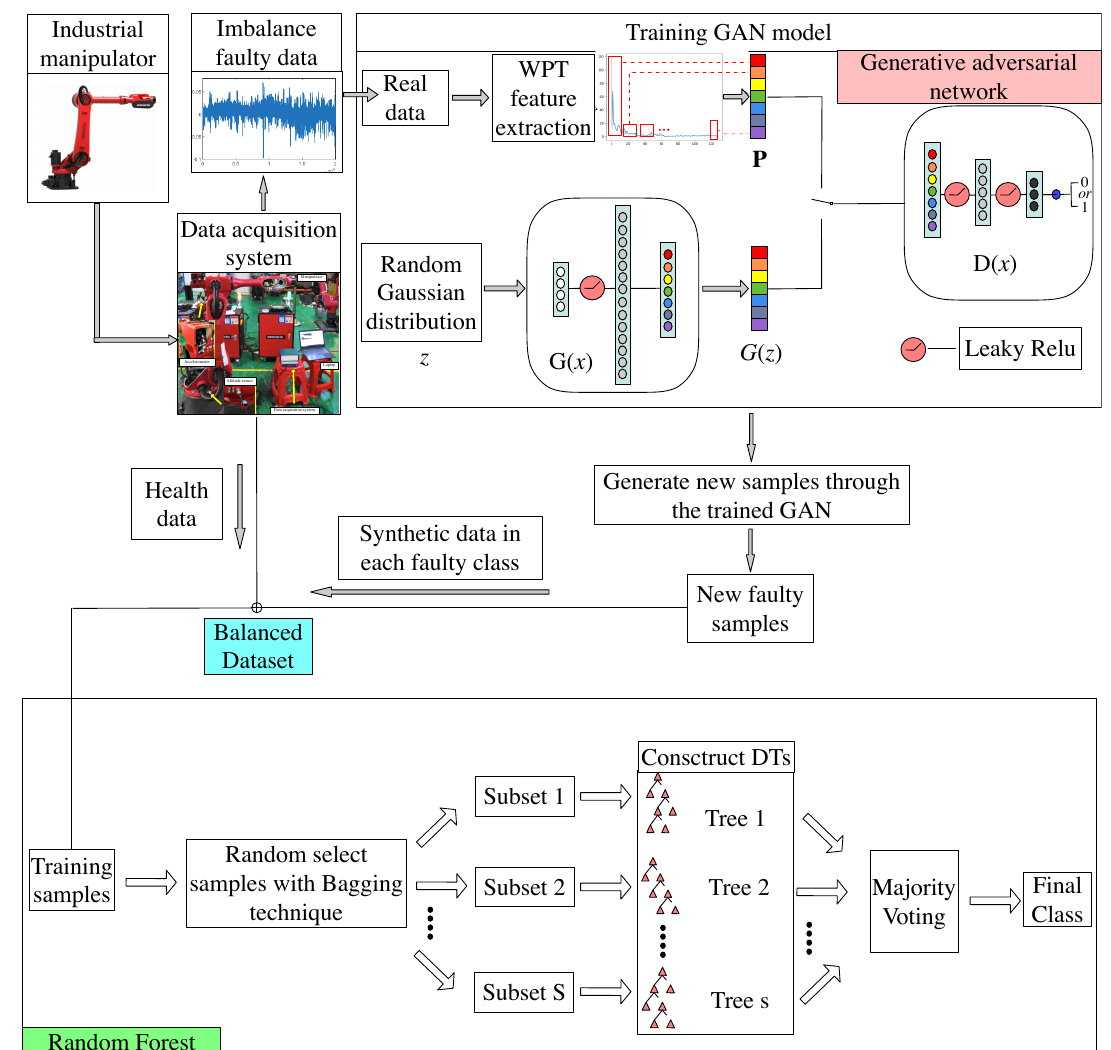
Figure 6. The complete data pipeline for fault diagnosis of the